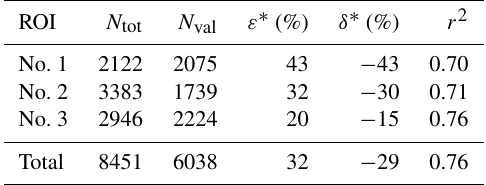
Table 2. Comparison between the regional MLP( R MER rs ) and the standard MER API2 (the locations of ROIs are presented in Fig.